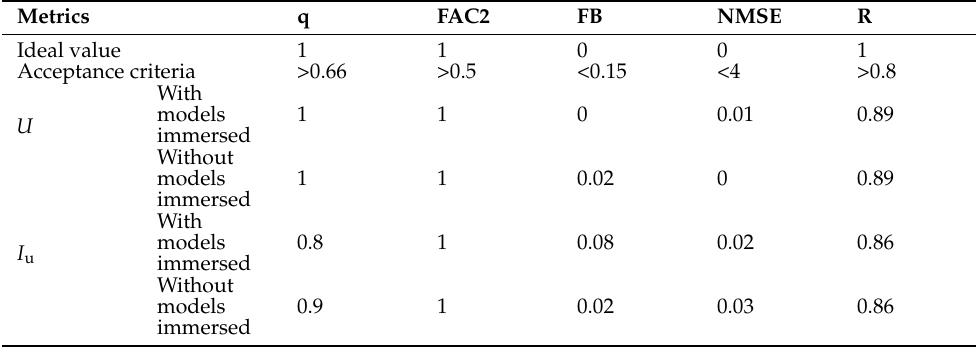
Table 2. Validation metrics for wind speeds U and turbulence intensities I u for